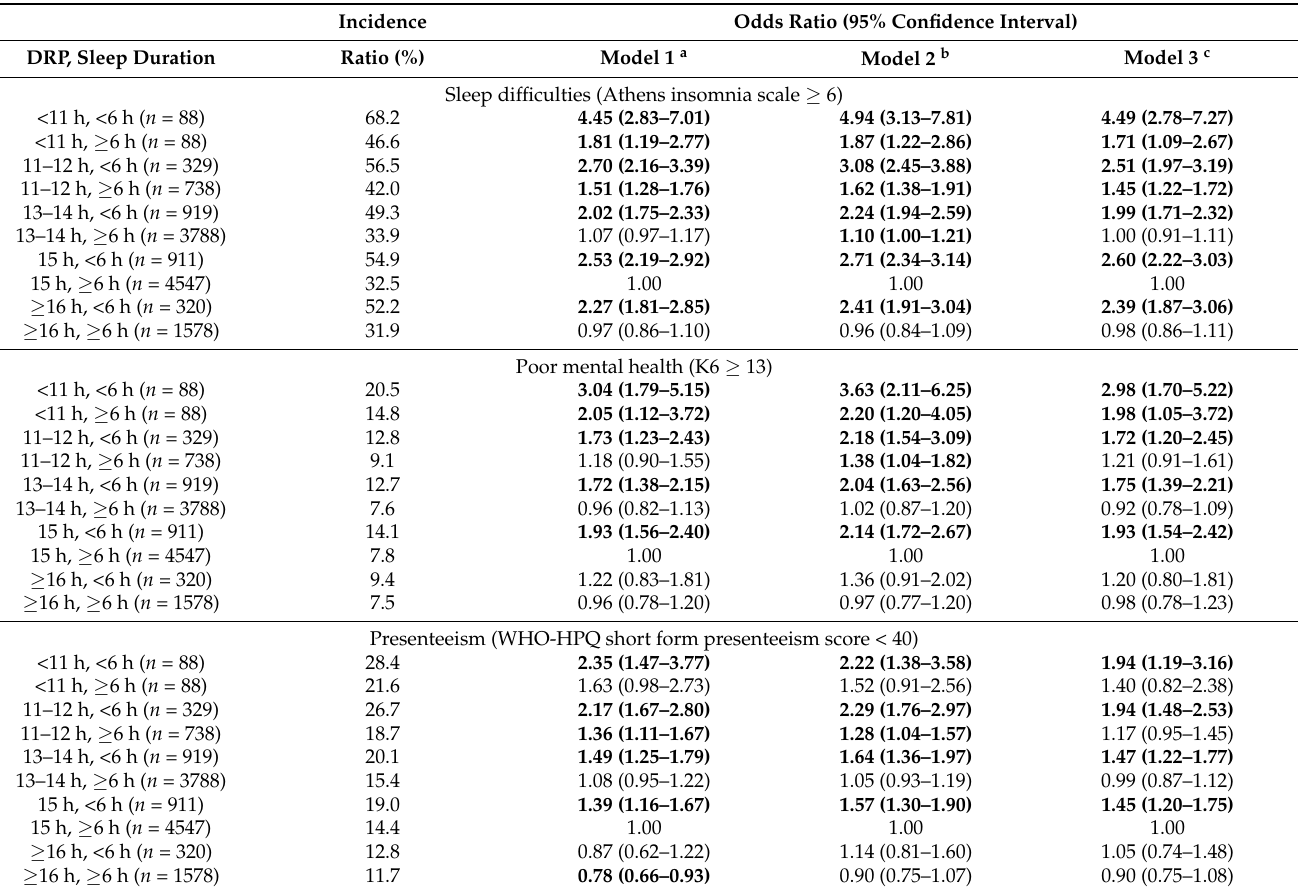
Table 2. Joint association of daily rest period (DRP) and sleep duration with sleep difficulty, mental health, and presenteeism ( n = 13,306). Incidence DRP, Sleep